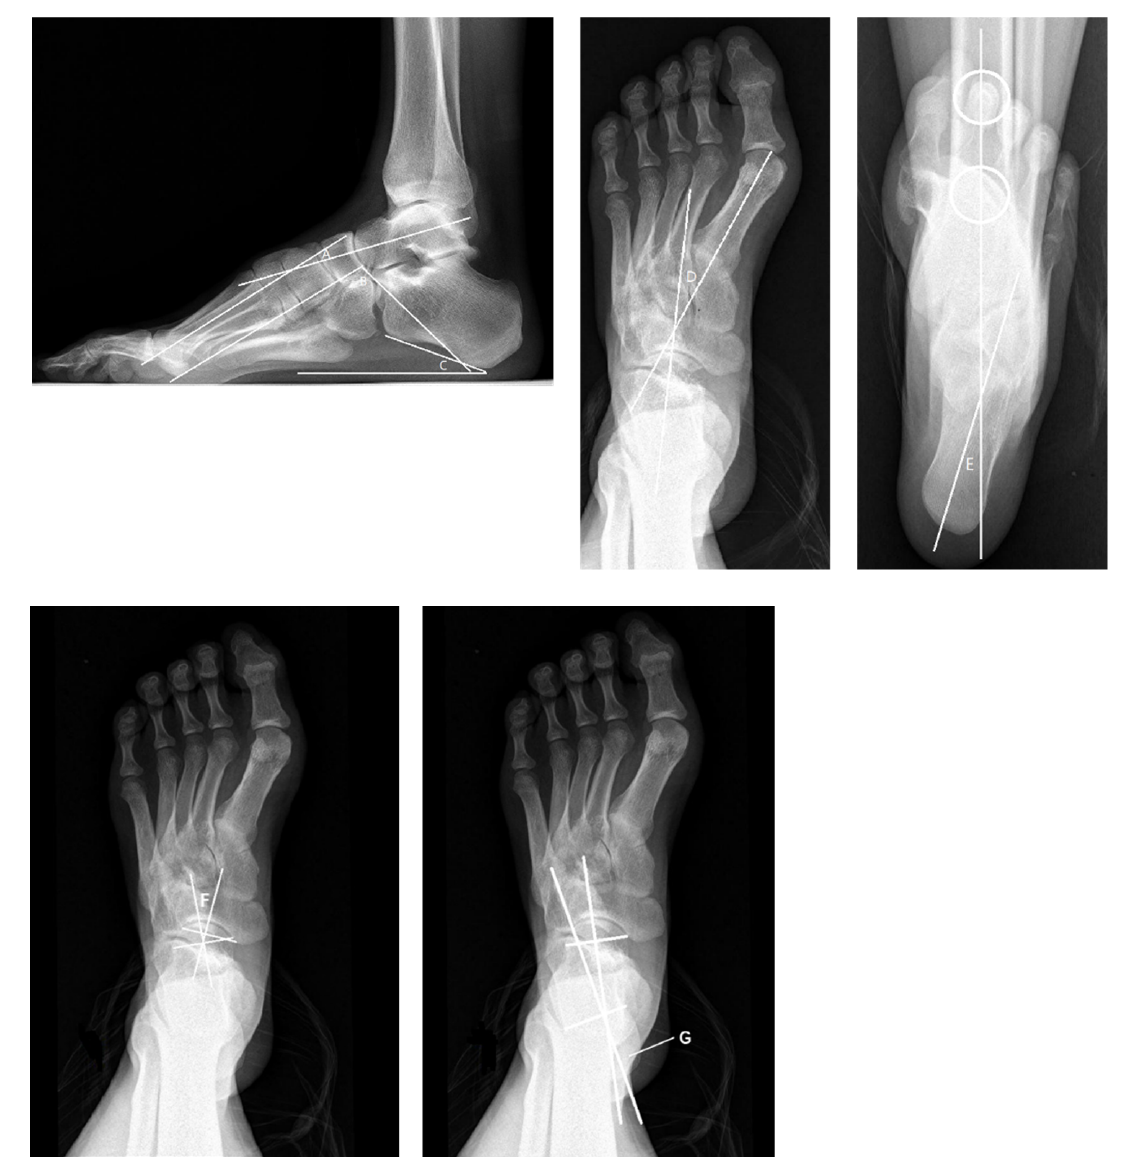
Figure 7. The radiological evaluation of cavus foot pre-operation. A: Meary Angle ( − 4°~4°) *. B: Djian – Annonier Angle (120°~130°) * C: Pitch Angle (20°~30°) * D: TM1 Angle (0°~20°) * E: TCA Angle (0°~5°) *. F: TN Coverage Angle (1.8°~19.3° male 6.7°~21.7° female) *. G: TC Angle (15°~35°) *. * Represent the normal range.